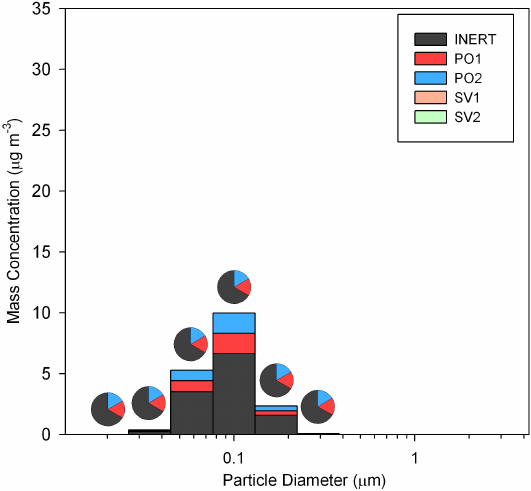
Fig. 2. Emitted and initial aerosol distribution for model simula- tions.